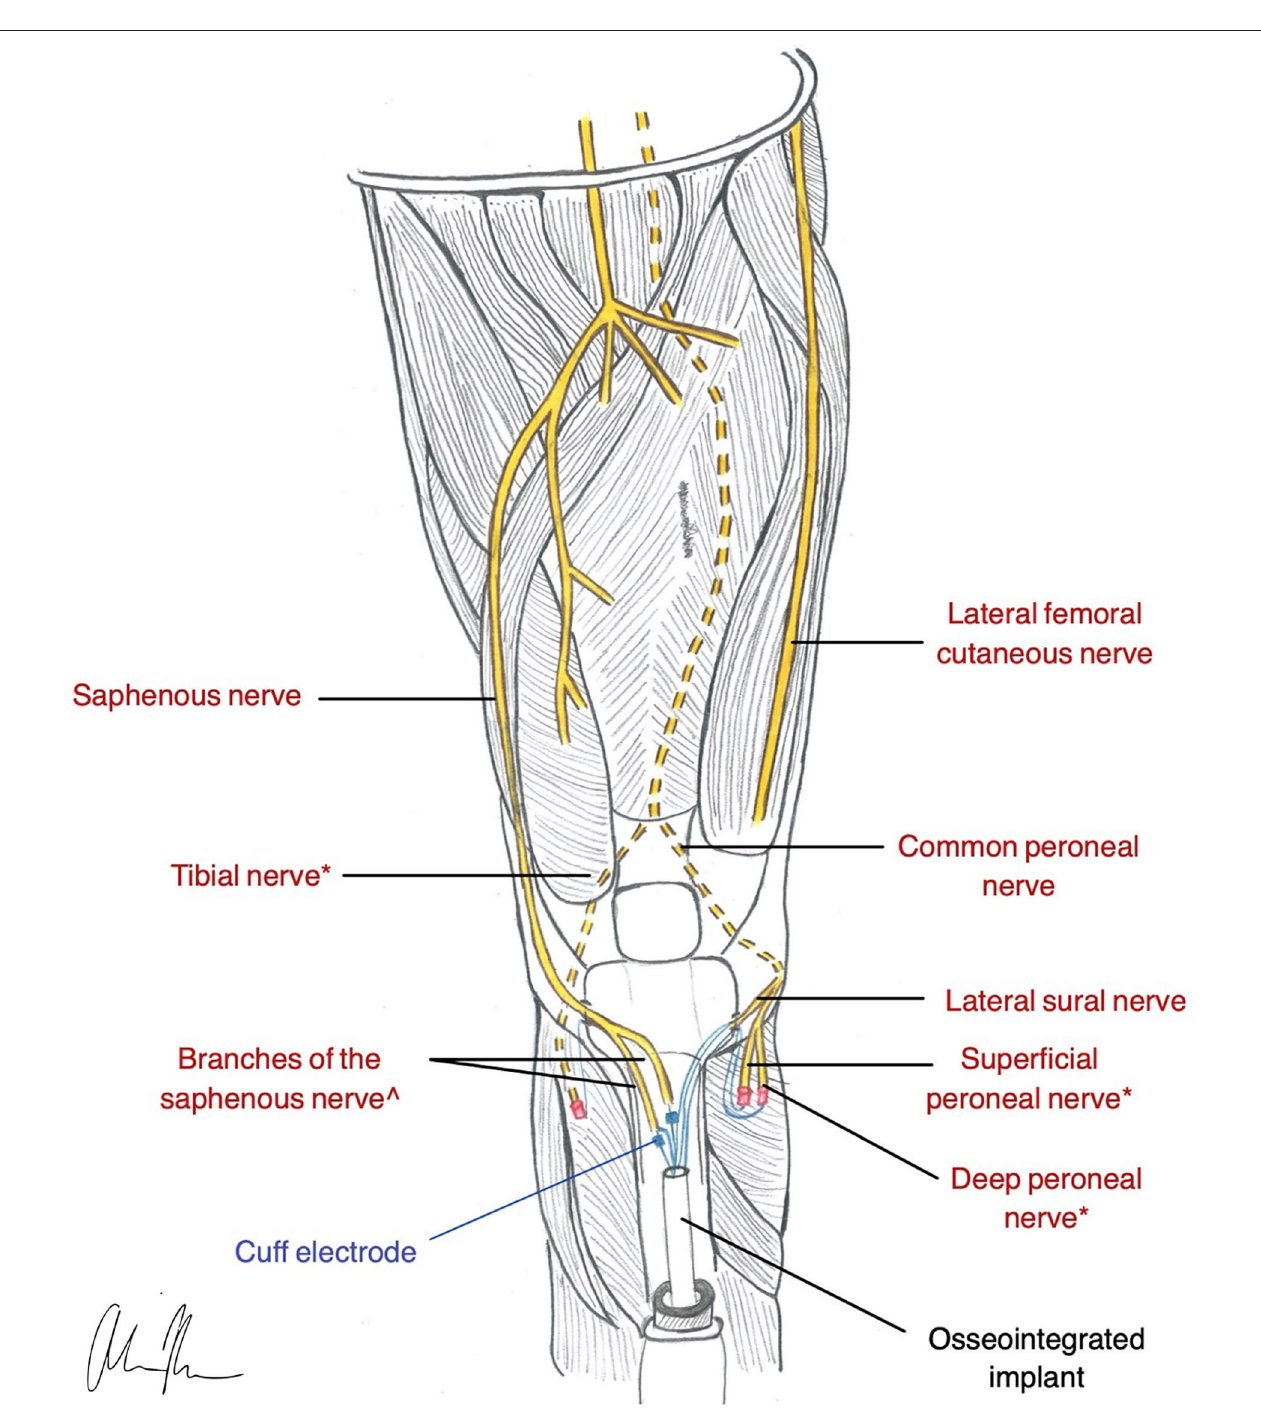
FIGURE 4 | Illustration of ONI construction in a transtibial amputee (Dingle et al., 2020b). * nerves are used for RPNI for motor control. ∧ nerves are used with a cuff electrode for sensation and are inserted into medullary canal via corticotomy in the Tibia.